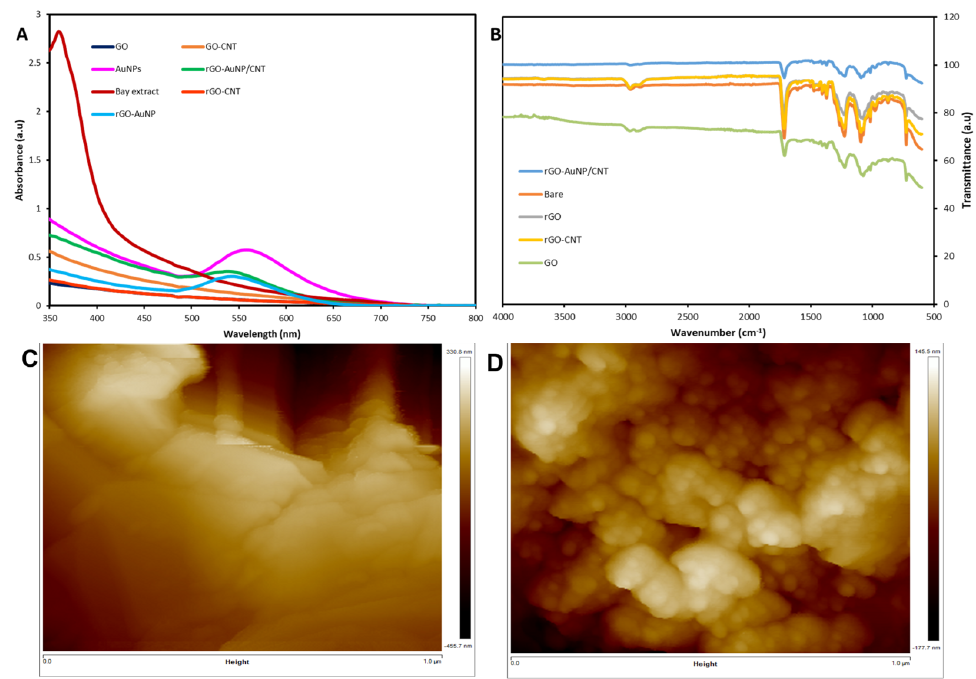
Figure 2. ( A ) UV−vis absorbance spectra of GO, AuNPs, bay laurel extract, rGO-AuNPs, GO-CNT, rGO-CNT, and rGO-AuNPs/CNT. ( B ) FTIR spectra of rGO-AuNPs/CNT/SPE, rGO, rGO-CNT, GO and bare SPE). ( C ) AFM images of bare SPE and ( D ) rGO-AuNPs/CNT/SPE as model electrodes.